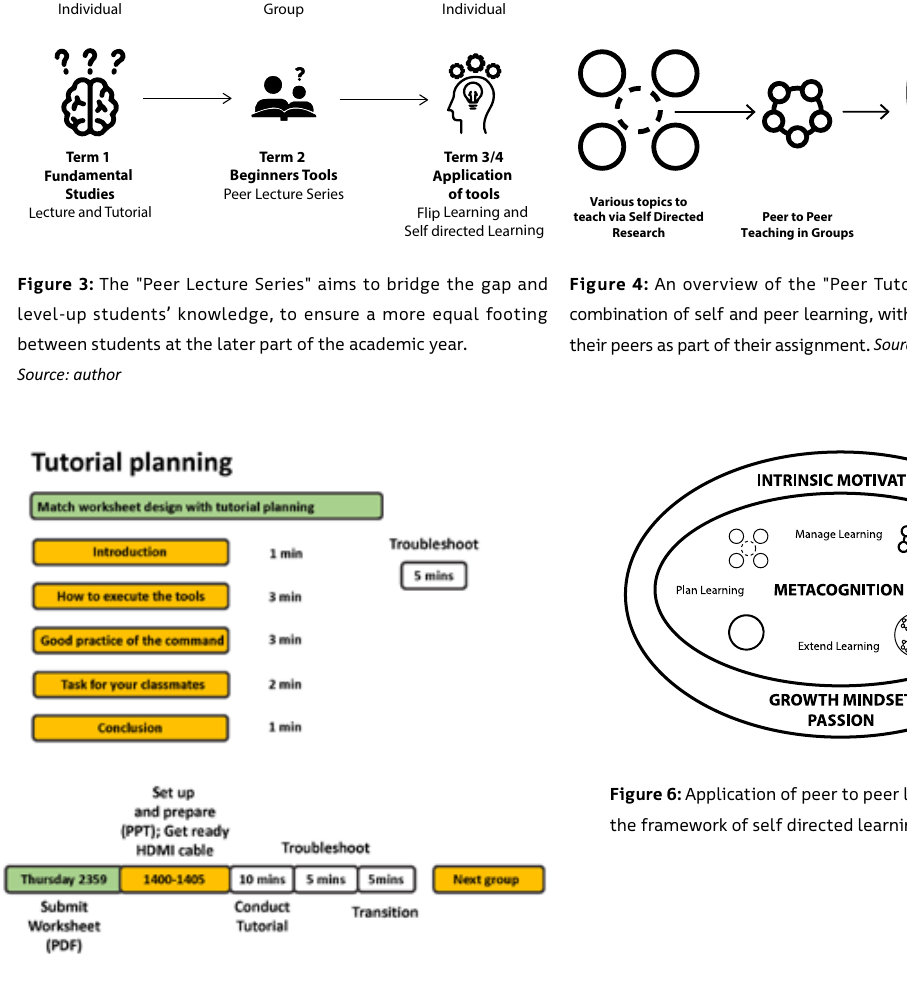
Figure 5: Tutor’s touchpoints with students before the final presentation, the lecture delivery; tutorial planning guide for students during the consultation. Source: author